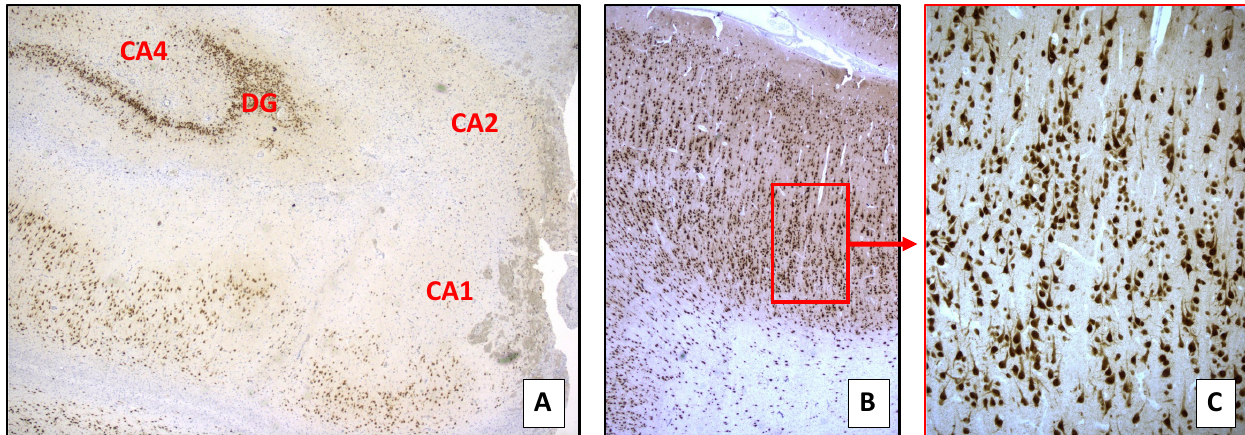
Figure 3. Histopathologic findings. ( A ) Hippocampal sclerosis type 1: pronounced neuronal cell loss along the whole Ammon’s horn (CA); preserved neuronal cellularity of the dentate gyrus (DG). (Neu-N immunostain, 2.5×). ( B ) Occipital lobe focal cortical dysplasia type I: mildly hypercellular cortex harboring small-diameter neurons arranged in distinct microcolumns. Note the cortex – white matter blurring. (Neu-N immunostain, 2.5×). ( C ) Occipital lobe focal cortical dysplasia type I: higher magnification of red insert in ( B ), highlighting the cortex microcolumnar arrangement. (Neu-N immunostain, 20×).